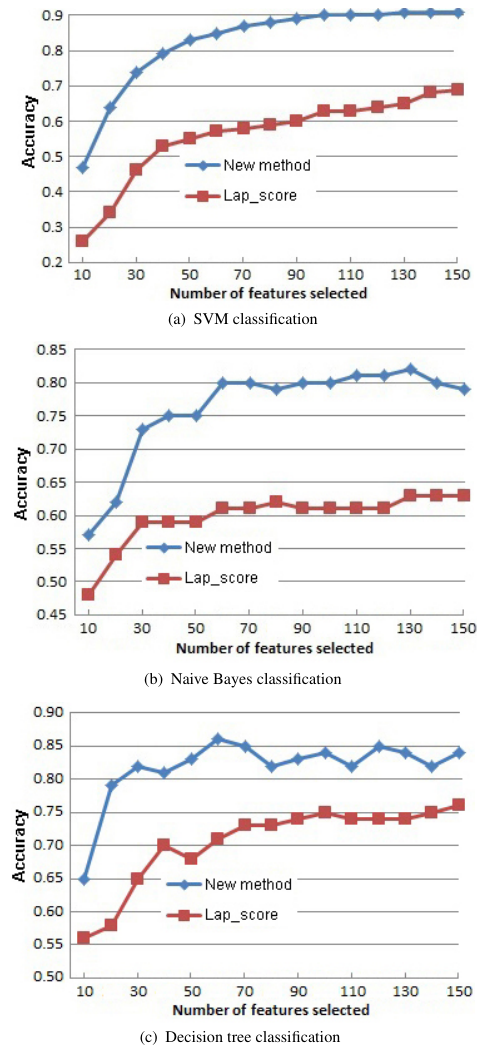
Fig. 3 Performance comparison of new FS with unsupervised